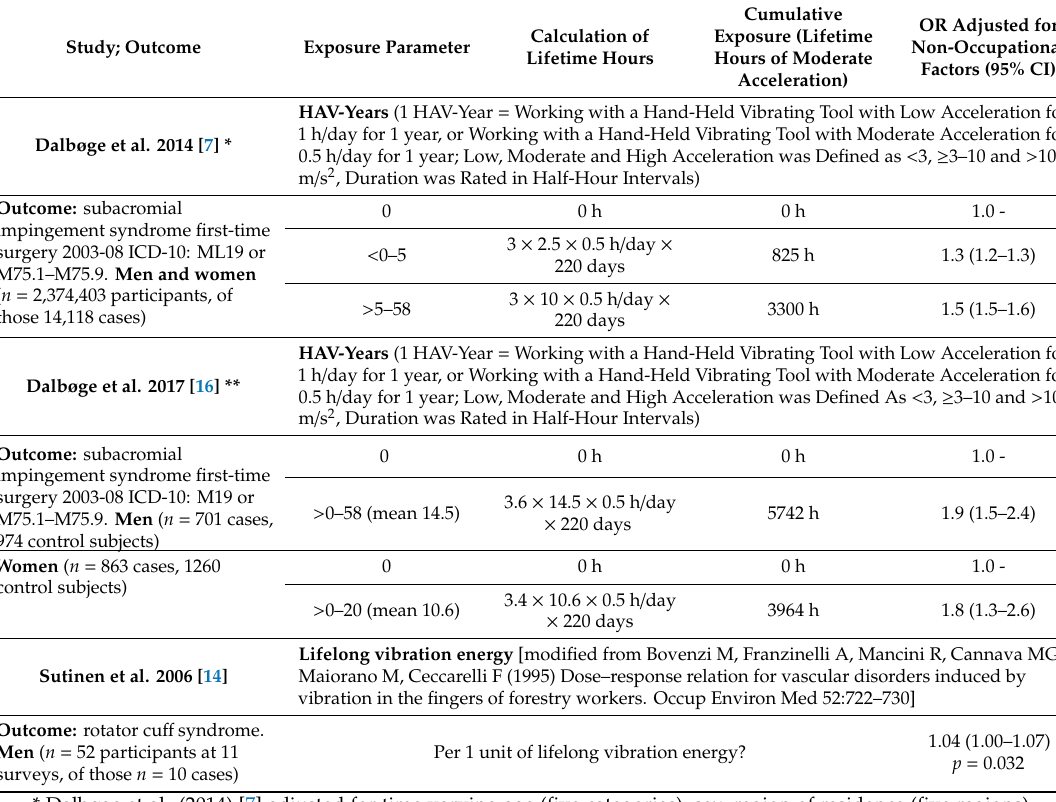
Table 6. Working with vibration of the hands and